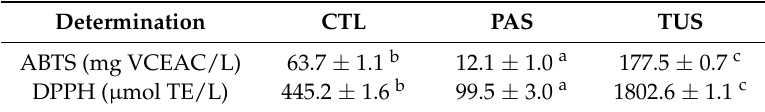
Table 2. Antioxidant activity of the n- hexane extracts from blackberry